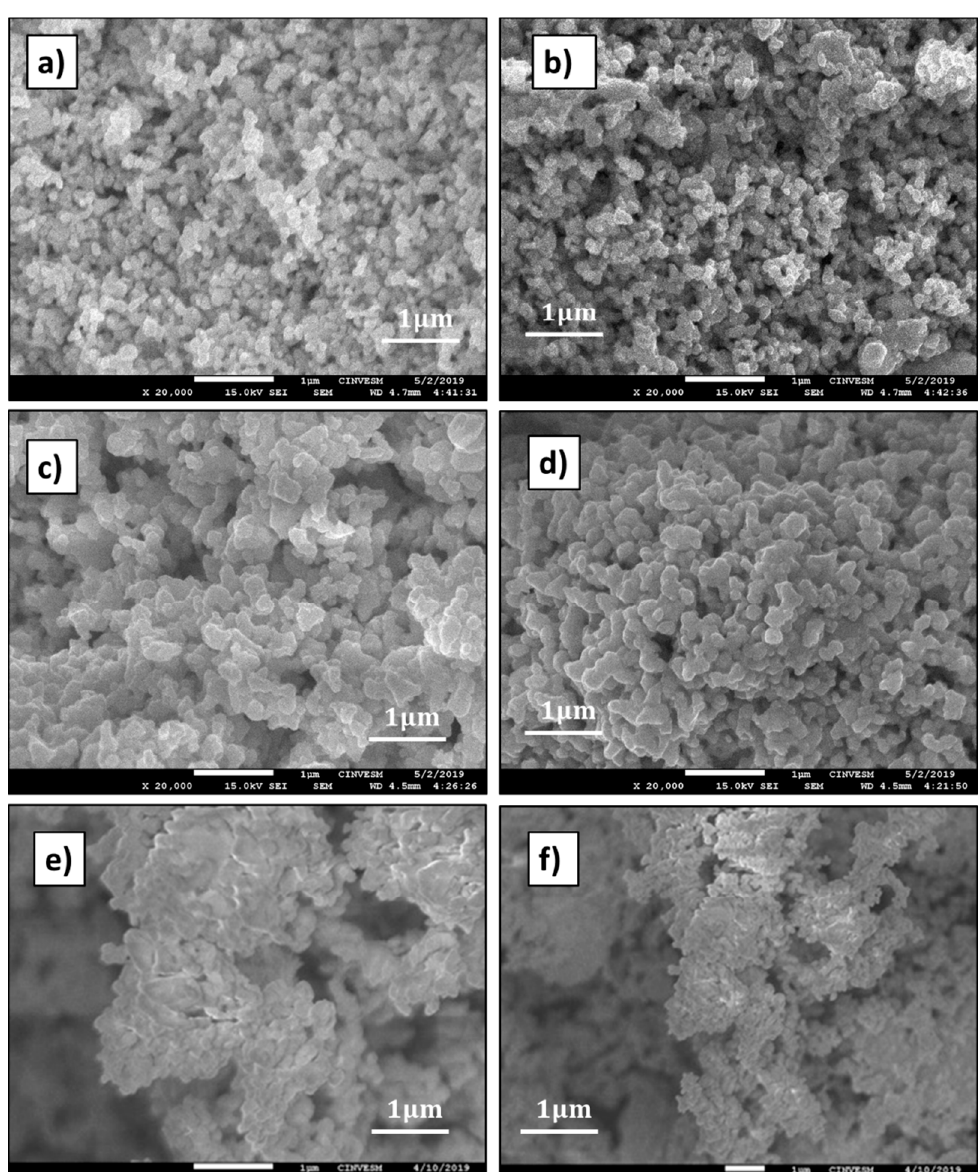
Figure 1. Scanning electron microscopy (SEM) images of ( a ) Bi 2 Mo 0.95 Ru 0.05 O 6 (MBR1), ( b ) Bi 2 Mo 0.97 Ru 0.03 O 6 (MBR2), ( c ) CeO 2 /Bi 2 Mo 0.95 Ru 0.05 O 6 (OCMBR1), ( d ) CeO 2 /Bi 2 Mo 0.97 Ru 0.03 O 6 (OCMBR2), ( e ) Au / Bi 2 Mo 0.95 Ru 0.05 O 6 (AuMBR1), and ( f ) Au / Bi 2 Mo 0.97 Ru 0.03 O 6 (AuMBR2)